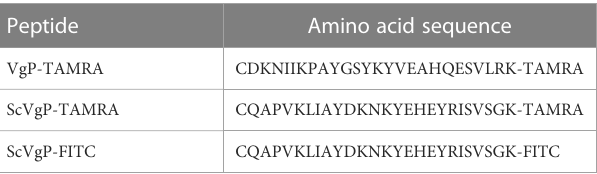
TABLE 1 Compositions of the VgP and ScVgP sequences used in this study. Peptide Amino acid